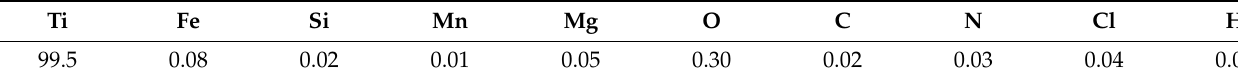
Figure 1. Microstructures of the base metal: ( a ) C/C composites, ( b ) Cu alloy. Table 1. Chemical composition of Ti powder ( ≤ wt.%).